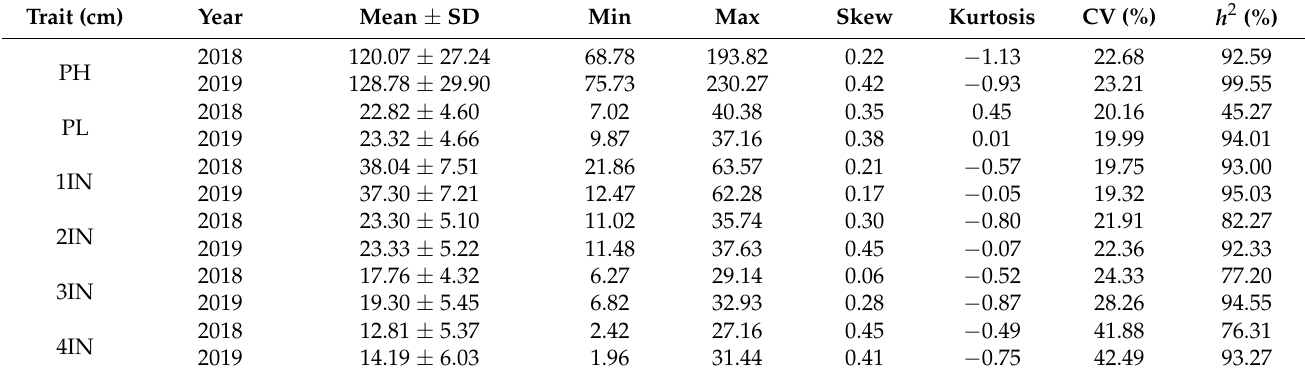
Table 1. Descriptive statistics of phenotypic performance of 504 rice accessions for PH and its component traits in natural population across 2